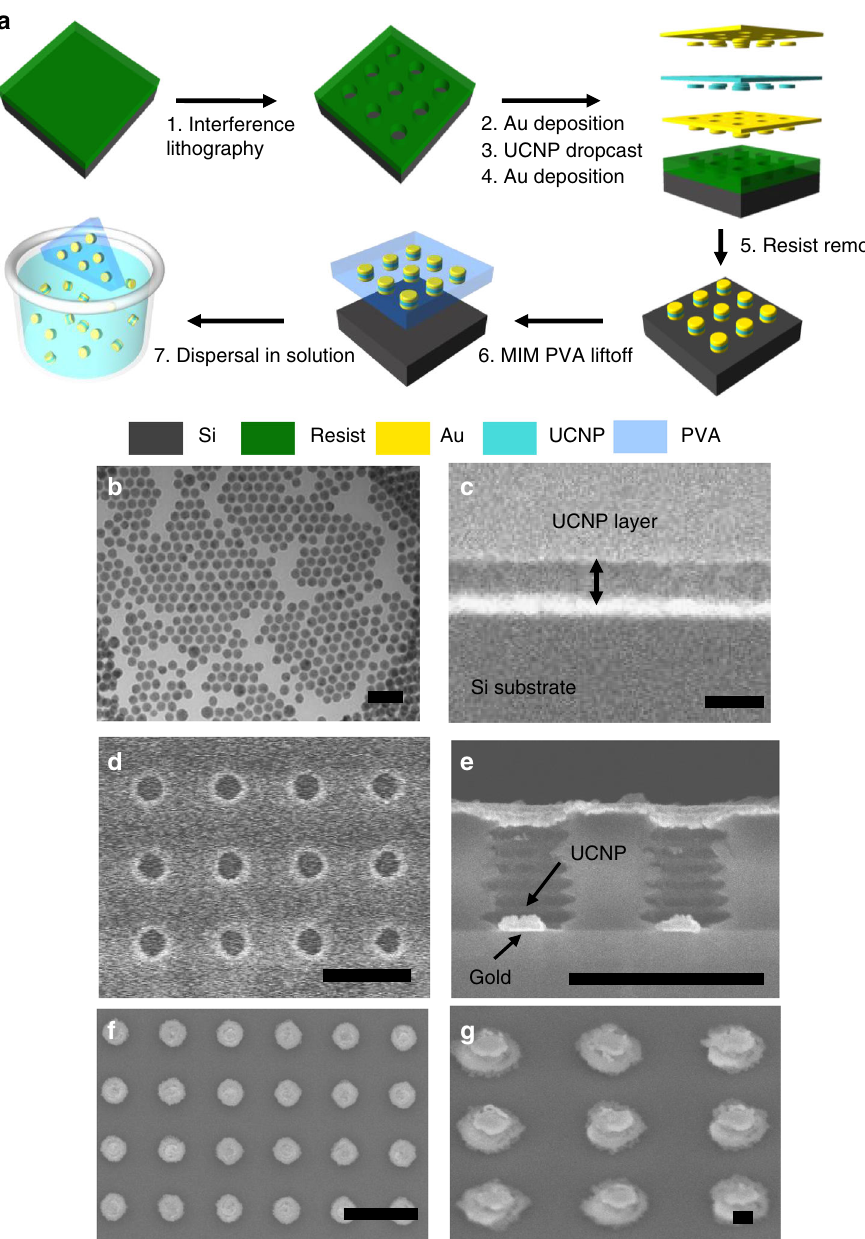
Fig. 2 Metal – insulator – metal (MIM) fabrication process. a Negative resist is exposed using a Lloyds mirror setup to create a hole array template. Metal layers are deposited via thermal evaporation and upconversion nanoparticle (UCNP) insulator layer is deposited using a dropcast method. Once this is done, the resist template is removed using acetone and the resultant array of MIM structures can be removed using polyvinyl alcohol and dissolved into water. b Transmission electron microscope (TEM) image of UCNPs used in the experiment. c Scanning electron microscope (SEM) image of reference used in the experiment. The dropcast method used to deposit the UCNP layer in our samples results in a uniformly thick layer of UCNPs. d Top-down SEM image of resist hole array template. Diameter of holes can be easily varied by varying the resist exposure time. e Cross-sectional SEM image of resist hole array template after the UCNP dropcast step. The bottom gold layer and UCNP monolayer is seen within the holes. The top of the holes is warped by the dropcast process and has a smaller diameter than the original hole diameter. f Top-down SEM image of MIM sample after the resist is removed. The MIMs are highly uniform with consistently large photoluminescence enhancement visible across the whole sample. g Angled SEM image of MIMs after resist removal. Due to warping of the hole diameter during the fabrication process, the top gold diameter is smaller than the bottom gold diameter. Scale bars: b , c 100 nm; d – f 1 μ m; g 100 decay rate due to quenching by the gold layers. By dividing the shorter decay times. This is because at high power densities the MIM decay rate by the reference decay rate, we get a visible intermediate energy levels are highly populated so the energy quenching factor, Q VIS , of 1.4. Figure 4b and c show the decay of transfer upconversion rate is increased, resulting in a faster NIR emission from the reference and the MIM at various power overall decay rate for the NIR emission 33 . In the strong excitation regime, we measure a decay rate of 3.00 × 10 4 s − 1 for the MIM densities. For both samples, higher power densities result in